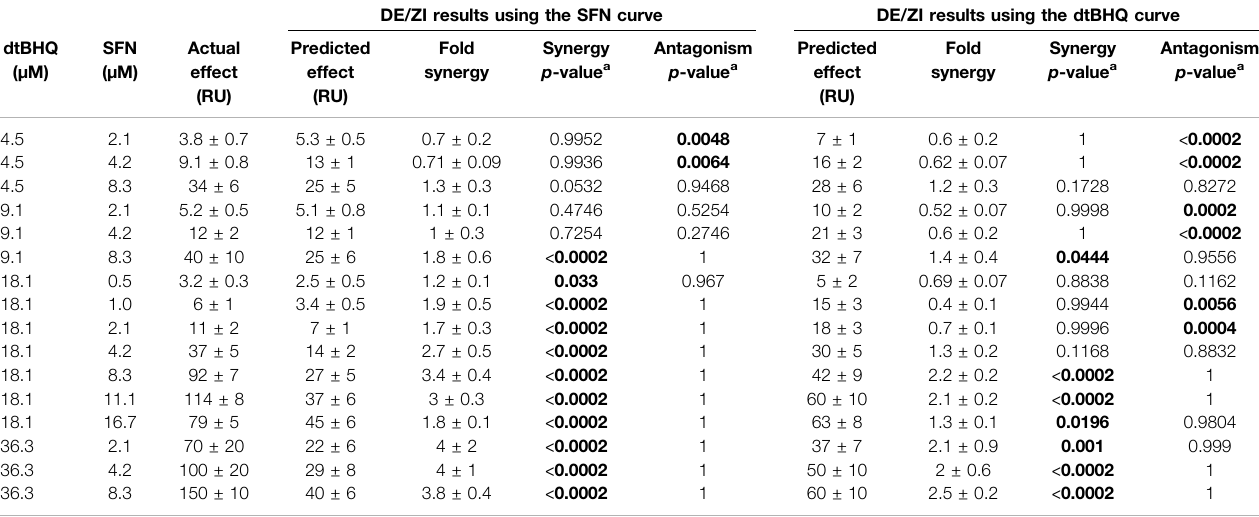
TABLE 1 | Results of analyzing ARE-reporter expression data in HaCaT cells treated with SFN and dtBHQ using the R code DEZI nearest neighbor.R . DE/ZI results using the SFN curve DE/ZI results using the dtBHQ curve